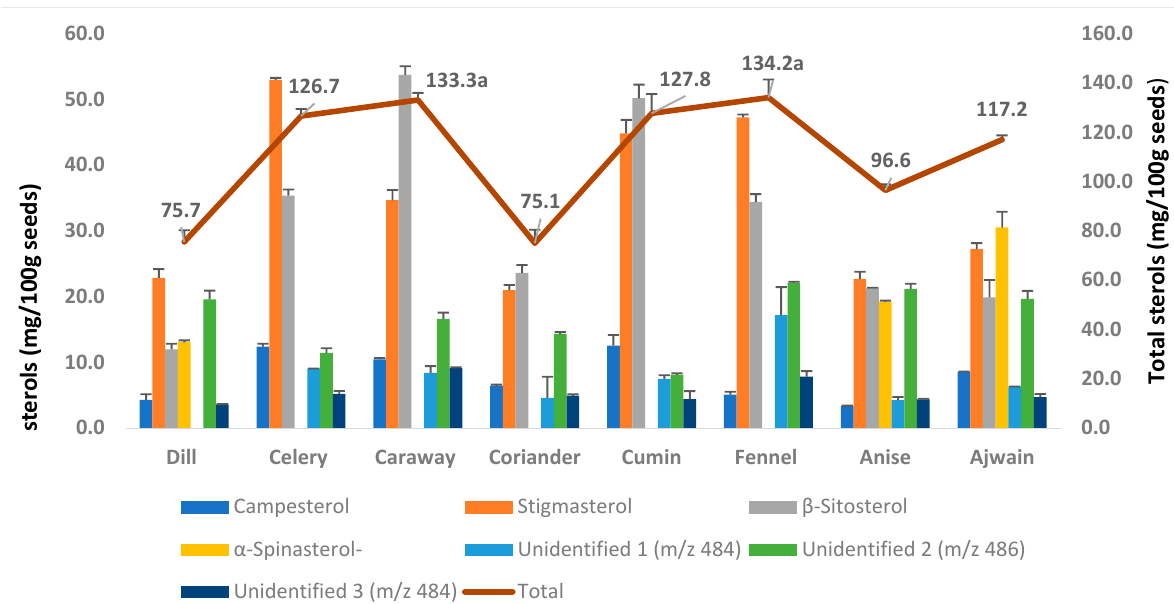
Figure 5. Phytosterol composition (mg/100 g seeds; dry weight basis) of studied Apiaceae family seed spices. Values are mean ± standard deviation of six replicates. The secondary axis represents the line graph. a The mean value is significantly highest among the studied spices ( p < 0.05; Turkey HSD).